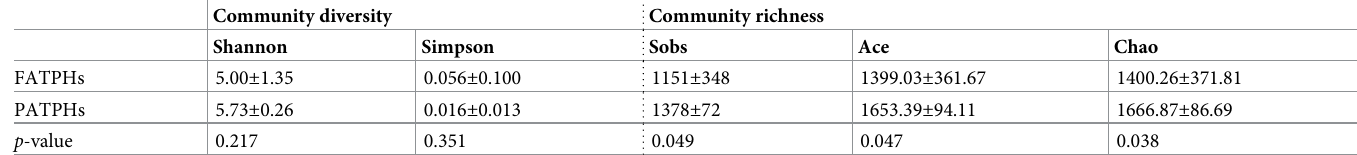
Table 3. Comparison of mean value of alpha diversity in indexes of Shannon, Simpson, Sobs, Ace and Chao between FATPHs and PATPHs.